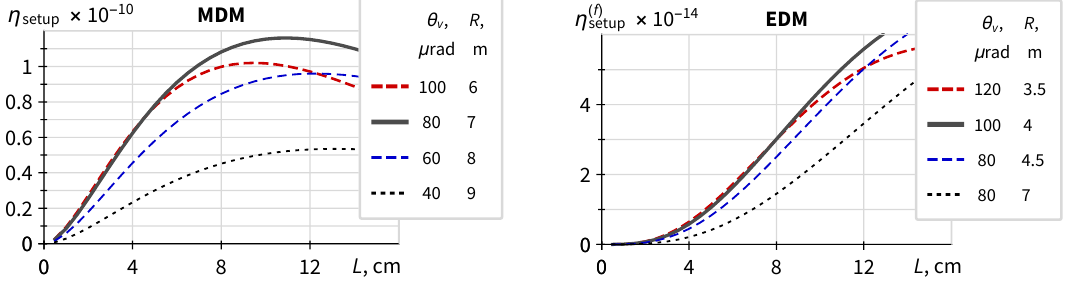
Figure 8 . Setup e(cid:14)ciencies (left) for MDM measurement (cid:17) setup and (right) for EDM measurement (cid:17) ( f ) as a function of the second crystal length, L , for various values of the angle (cid:18) v and optimal setup radii of curvature R (listed on the